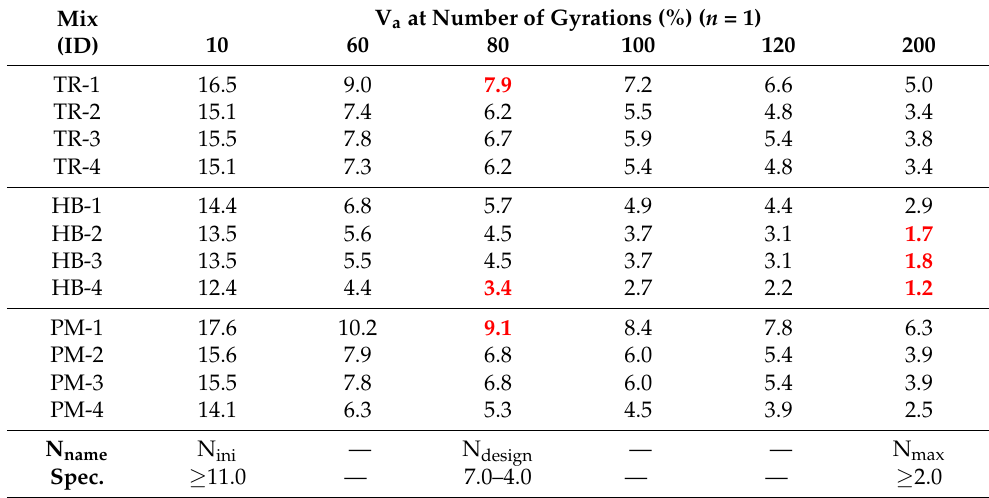
Table 6. Air voids (V a ) obtained from the SGC